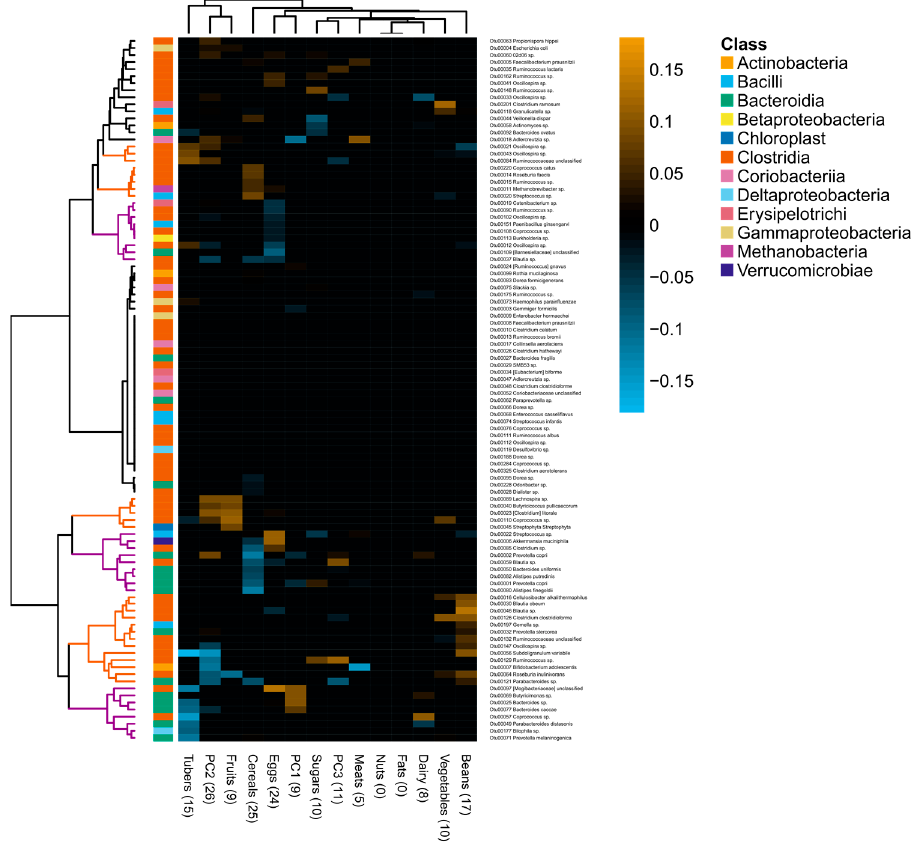
Figure 4. Heatmap showing Spearman’s correlation coe ffi cients between OTU relative abundance and food-group intake. The set of OTUs associated with multivariable-adjusted food-group intake was obtained with a regression-based random-forest machine-learning algorithm. We also included the first three components of the food-group PCA. Dendrograms obtained by hierarchical Ward-linkage clustering. The colored branches of the dendrogram are for illustrative purposes: brown branches highlight OTUs associated with plant-derived food groups, while purple branches highlight OTUs associated with animal-derived food groups. The taxonomic classification at the class level of each OTU is noted at the left side of the heatmap. Values in parentheses in the x -axis indicate the number of OTUs selected by the random forest.